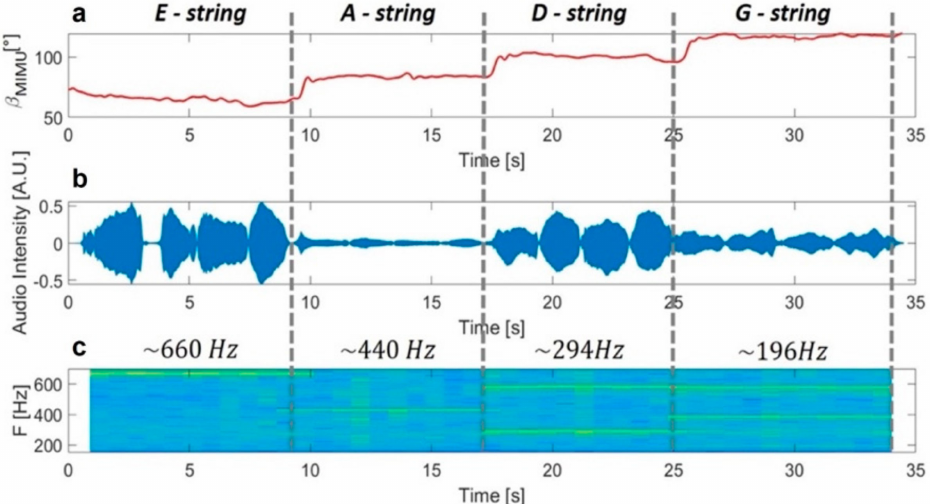
Figure 8. From the top: plot ( a ), β angle measured by Xsens; plot ( b ), audio track; plot ( c ), time– frequency analysis.